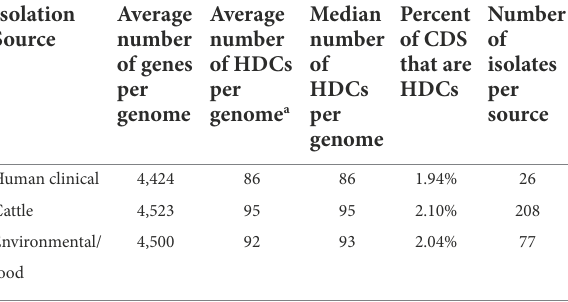
TABLE 1 Number of hypothetically disrupted coding sequences present in S. Cerro